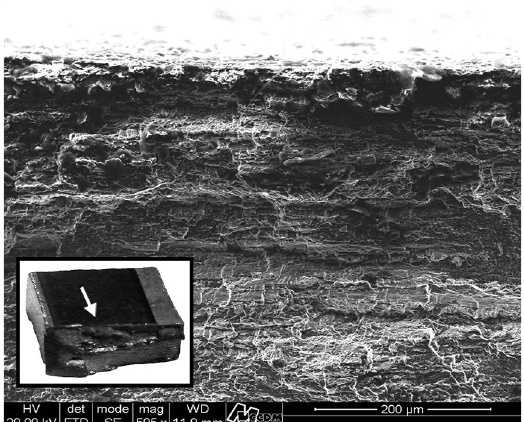
Figure 7. SEM micrograph of the fatigue initiation region of a laser- treated sample. The inset image is a macrograph of the fractured sample, and the arrow indicates the probable initiation